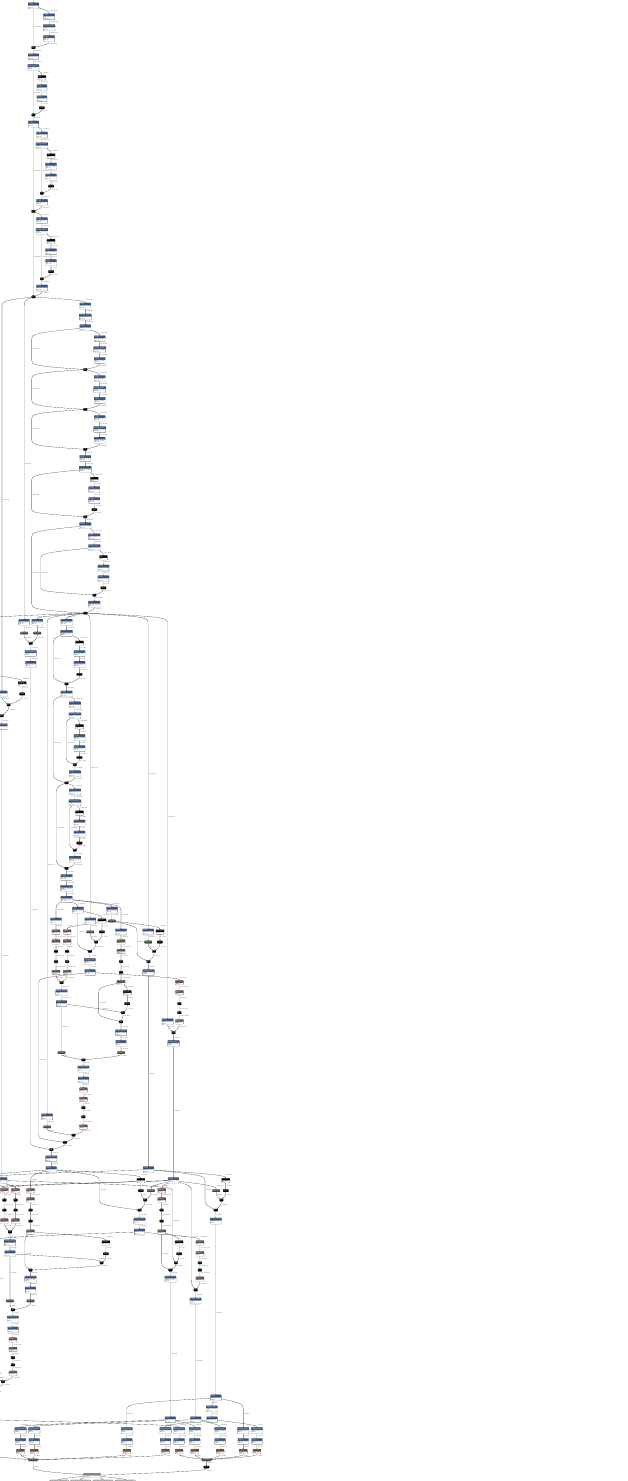
Figure A1. Structure of the convolutional neural network (CNN) used for bee identification.